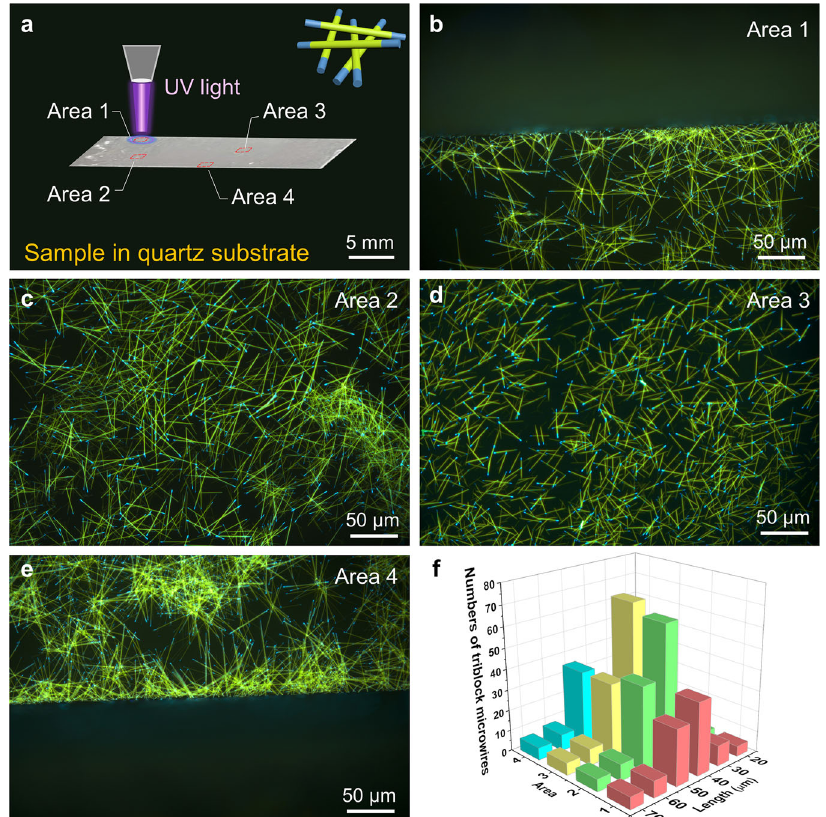
Fig. 3 Large-scale synthesis of blue-olive-blue triblock nanowire. a Randomly selecting the area to characterize the distribution of the blue olive blue triblock heterostructure in the quartz substrate. FM images of blue-olive-blue triblock nanowires in the area 1 ( b ), area 2 ( c ), area 3 ( d ) and area 4 ( e ). f The histogram of length distribution of triblock heterostructures, by randomly measuring the FM images of a large number of microwire samples. The length of the triblock nanowires ranges from 40 to 50 μ